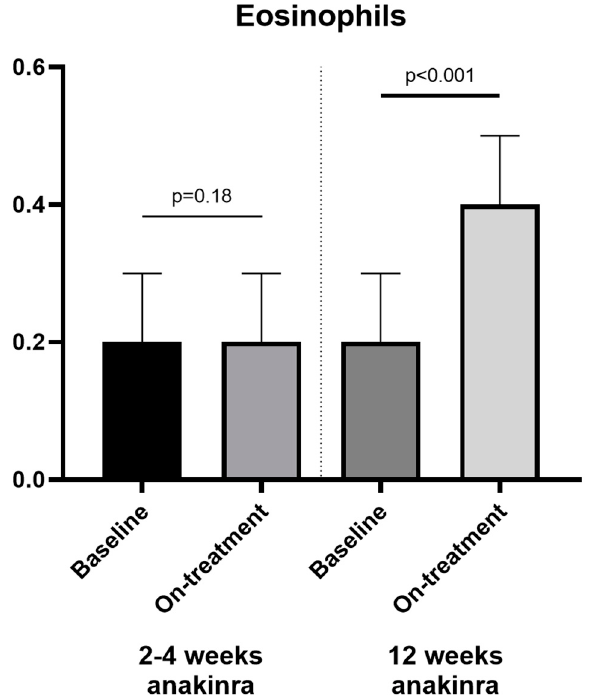
Figure 2. Duration of anakinra treatment and changes in eosinophils. We found a significant change in eosinophils between baseline and on-treatment analysis in the patients who received anakinra for 12 weeks ( right panel) and not in the 2–4 weeks treatment ( left panel).